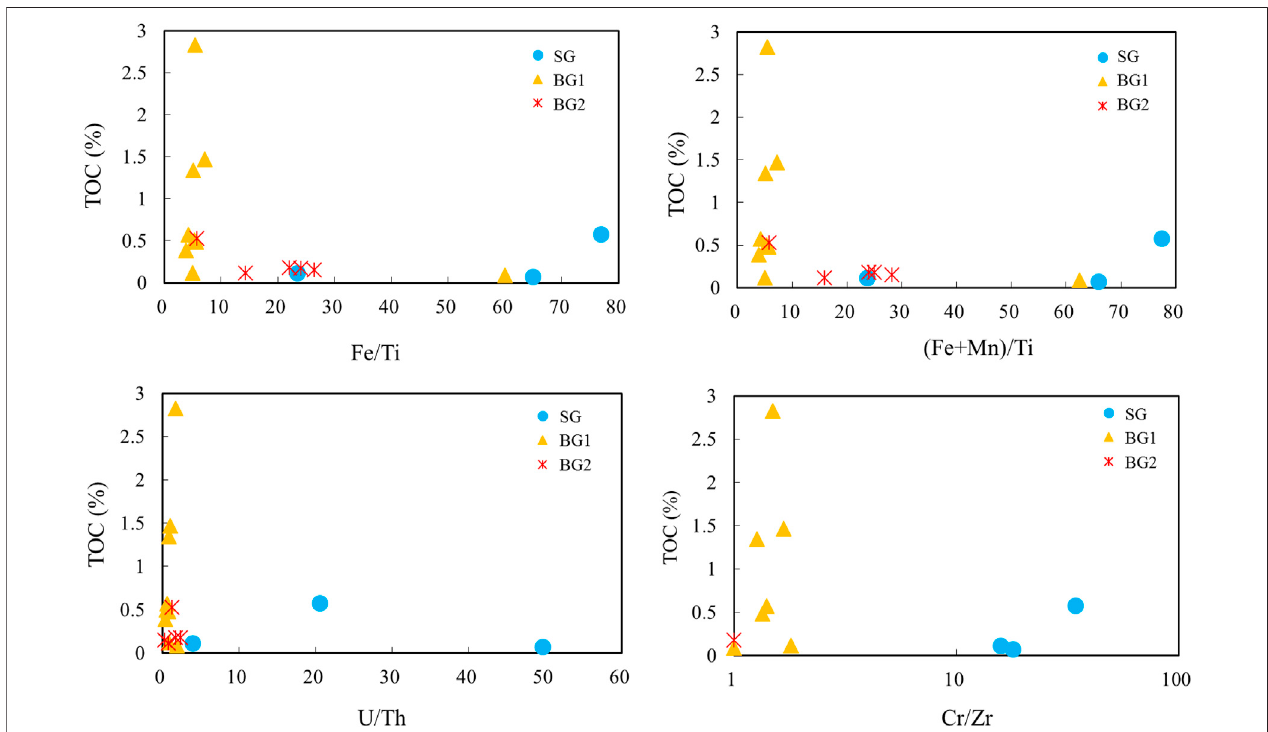
FIGURE 9 | Correlation between TOC and hydrothermal action indexes of the Yuertusi Formation samples in the Yutixi outcrop.